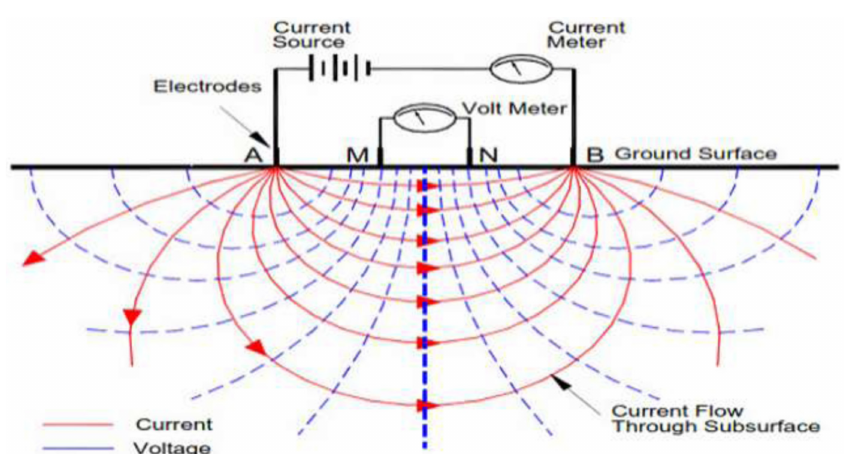
Figure 2. Schematic illustration of the VES technique and electrode arrangement for Schlumberger